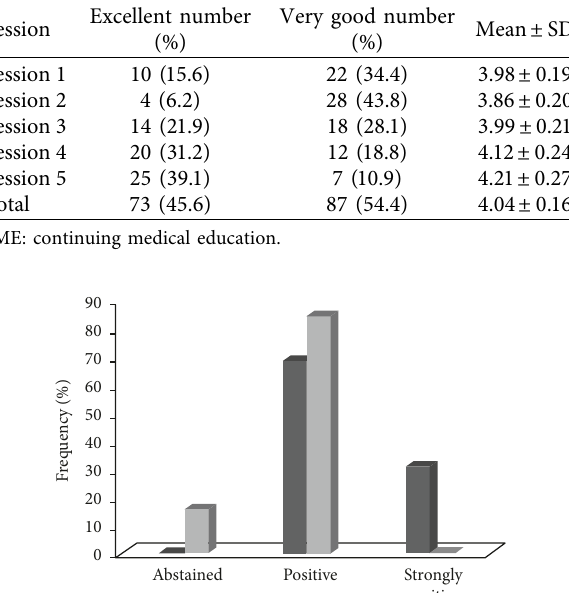
Table 2: The midwives’ satisfaction level with the content of electronic CME after participating in different education sessions